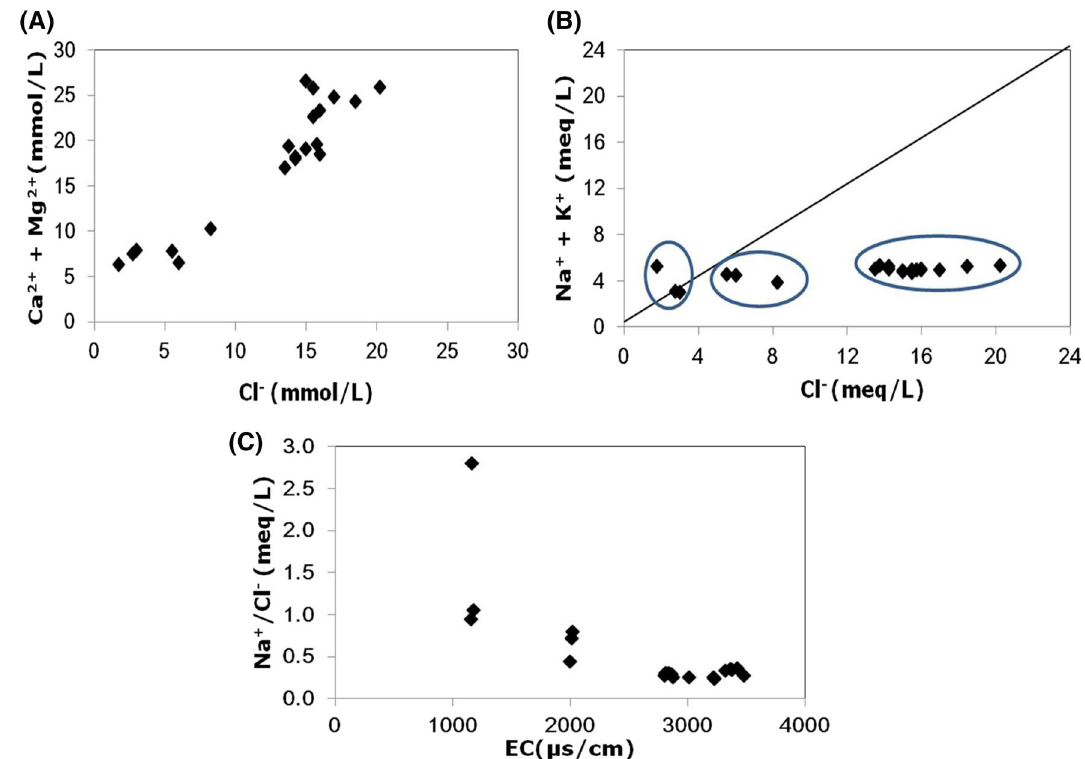
Fig. 5 Scatter plots for hydrogeochemical evolutionary processes, a scatter plot between Cl − and Ca 2+ + Mg 2+ , b scatter plot between Cl − and Na + + K + and c scatter plot between EC and Na + /Cl